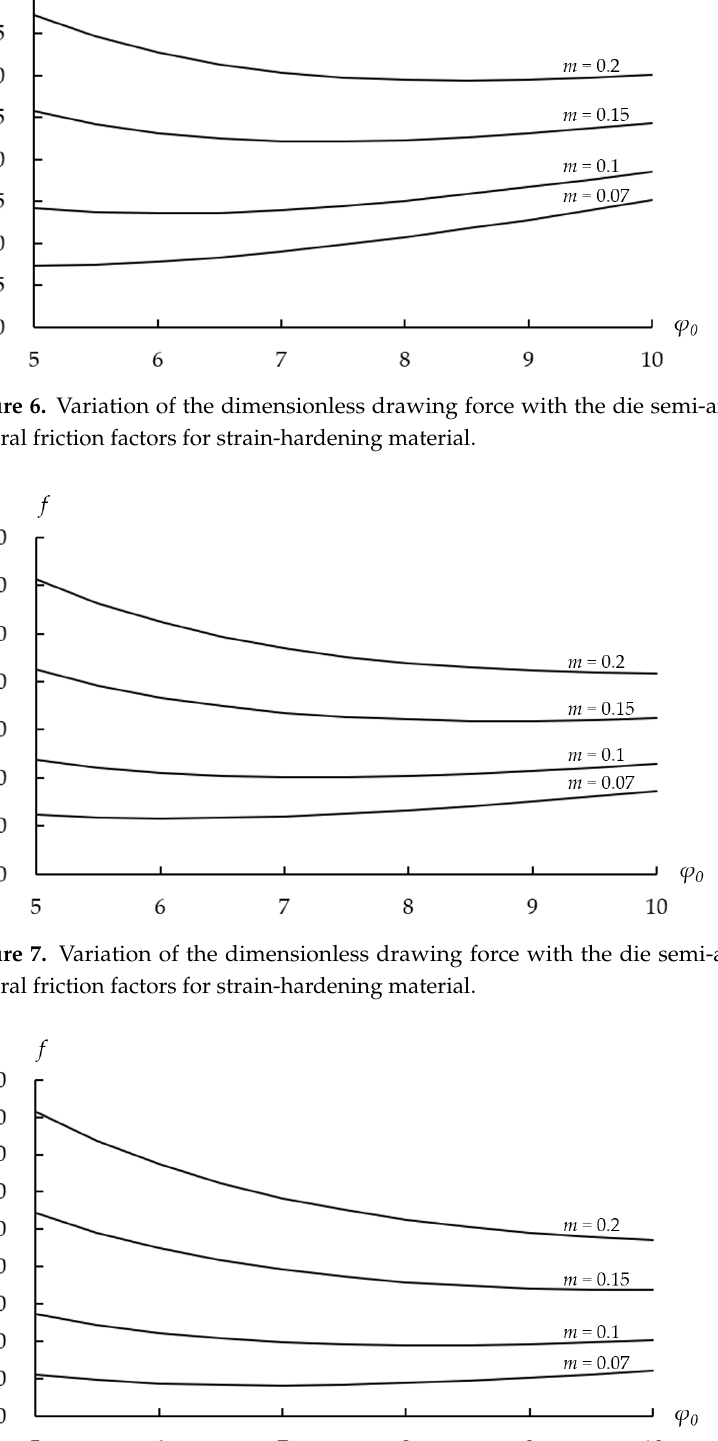
Figure 8. Variation of the dimensionless drawing force with the die semi-angle at R 1 several friction factors for strain-hardening material.